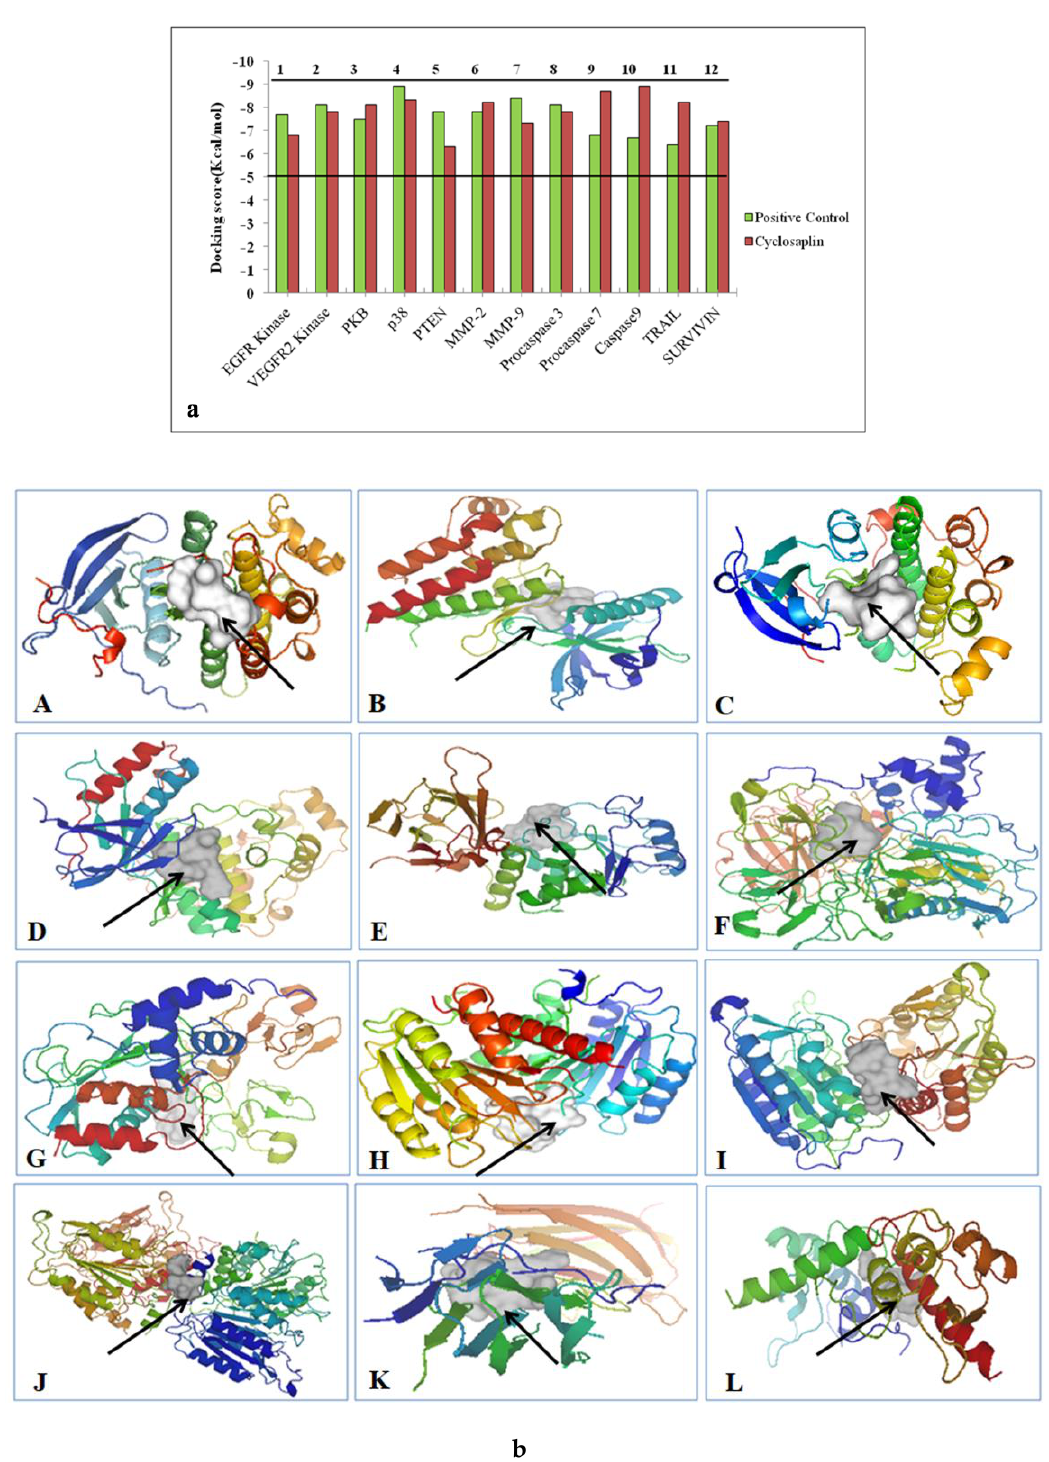
Figure 3. ( a ) Docking scores in kcal/mol for various cancer-related proteins. The binding affinities closer to 10 indicate efficient binding. ( b ) Cyclosaplin bound to different receptors. Cyclosaplin is shown in white, indicated by the arrows, and proteins are depicted with rainbow’s spectrum. ( A ) EGFR kinase. ( B ) VEGFR2 kinase. ( C ) PKB. ( D ) p38. ( E ) PTEN. ( F ) MMP-2. ( G ) MMP-9. ( H ) Procaspase 3 (previous study [11]). ( I ) Procaspase 7. ( J ) Caspase 9. ( K ) TRAIL. ( L ) SURVIVIN.